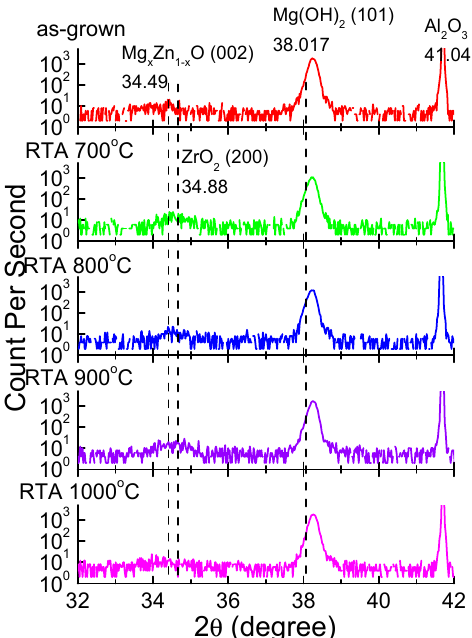
Figure 1. (Color Online) X-ray diffraction scan profiles of Zr-doped Mg x Zn 1 − x O (MZO) films annealed at various temperatures.